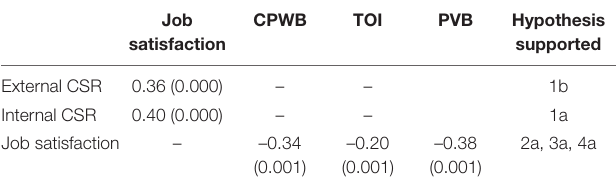
TABLE 5 | Testing of model.